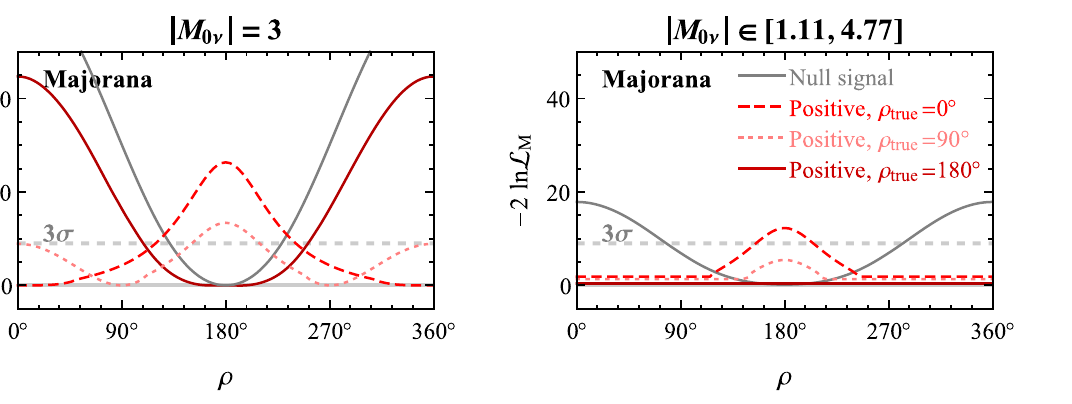
(cid:2) (cid:2) (cid:2) M (cid:2) = 0 eV and = 3 with 3 , true 0 ν true